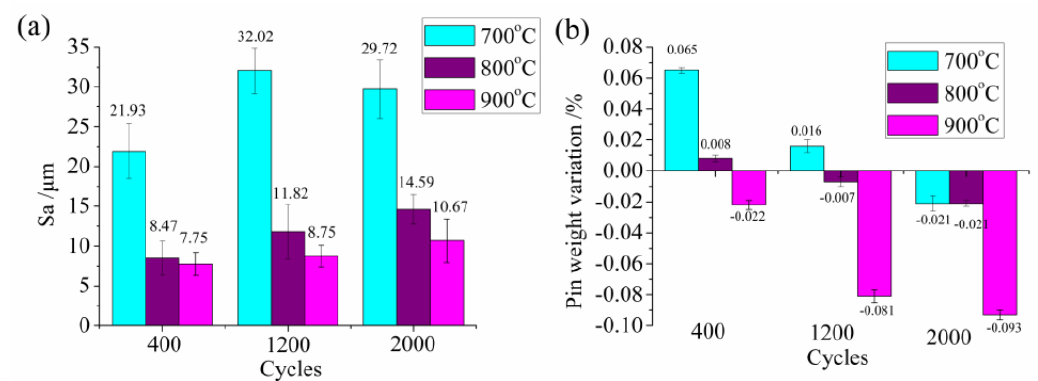
Figure 9. Surface roughness Sa ( a ) and weight variation ( b ) of the pins tested at different temperatures and measured after 400, 1200, and 2000 cycles.